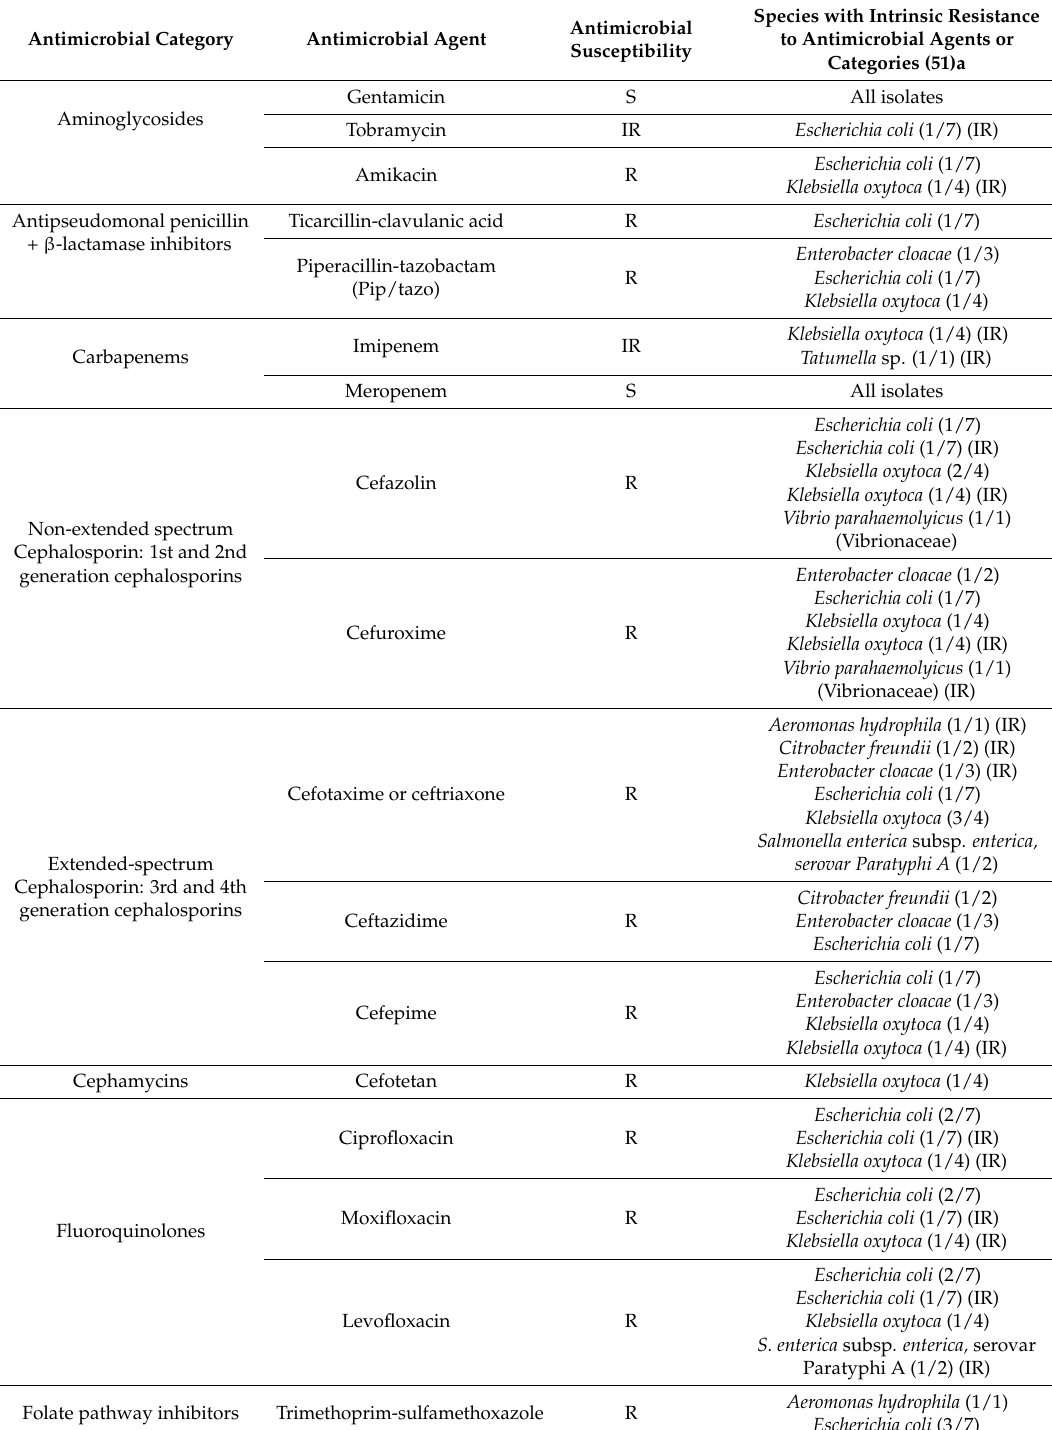
Table 3. Identification of enterobacteria demonstrating antibiotic resistance using the AutoScan ID panel database.